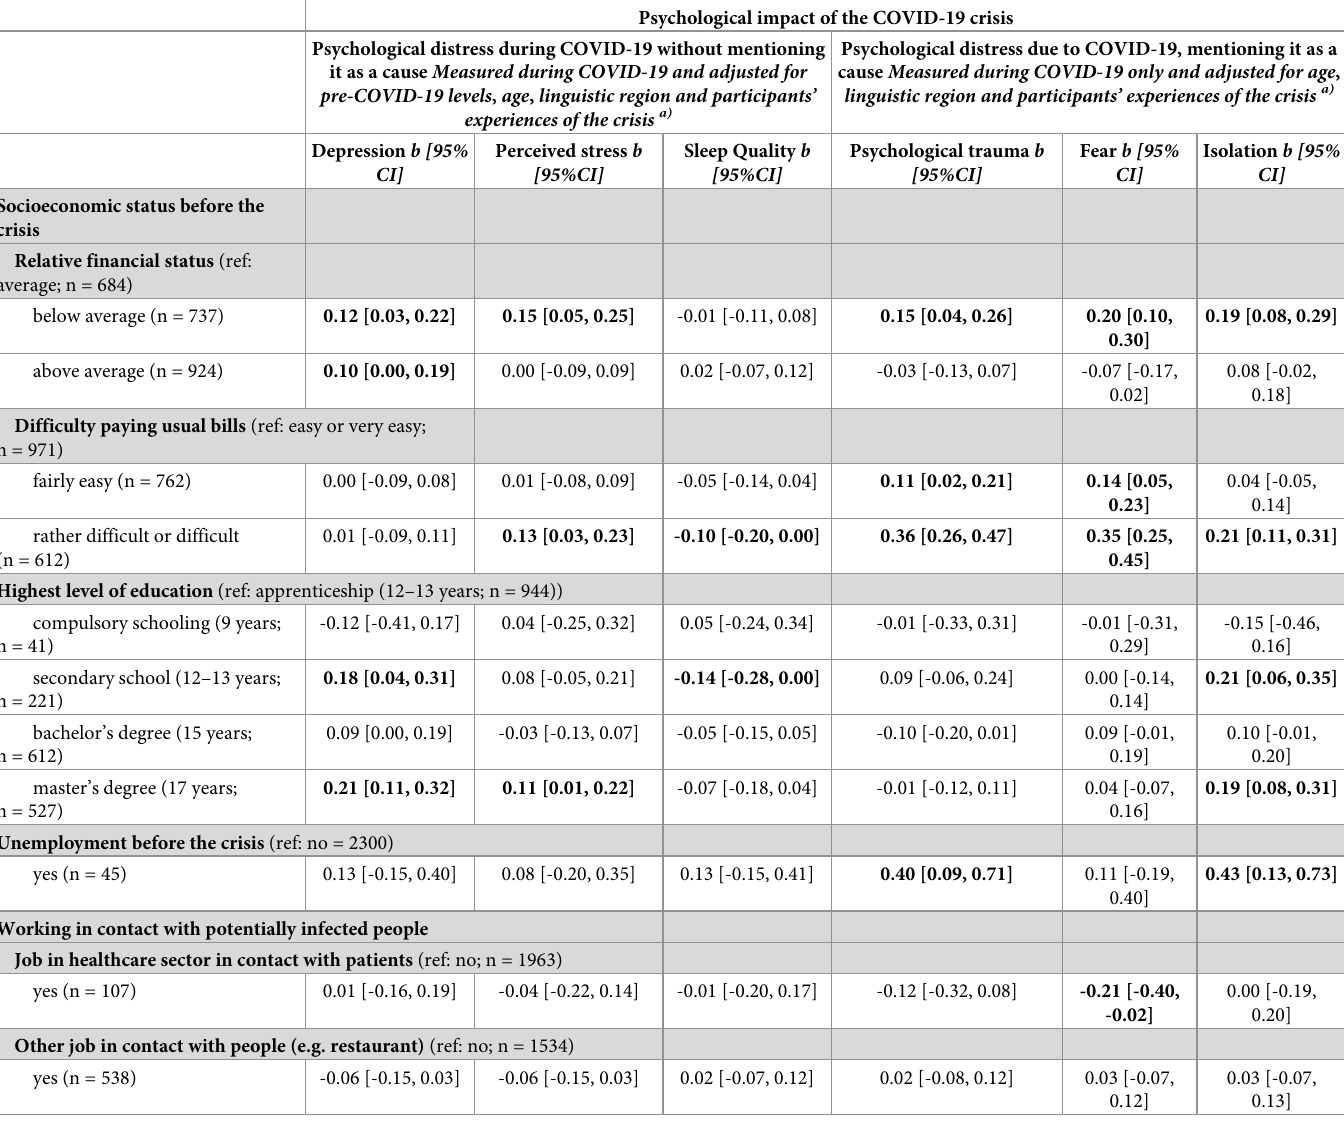
Table 5. Associations between the psychological impact of the COVID-19 crisis and socioeconomic status, highest level of education, unemployment before the cri- sis and working in contact with potentially infected people; adjusted for experiences of COVID-19 symptoms and work situation during the COVID-19 crisis. Psychological impact of the COVID-19 crisis Psychological distress during COVID-19 without mentioning Psychological distress due to COVID-19, mentioning it as a cause Measured during COVID-19 only and adjusted for age it as a cause Measured during COVID-19 and adjusted for pre-COVID-19 levels , age , linguistic region and participants’ experiences of the crisis a)